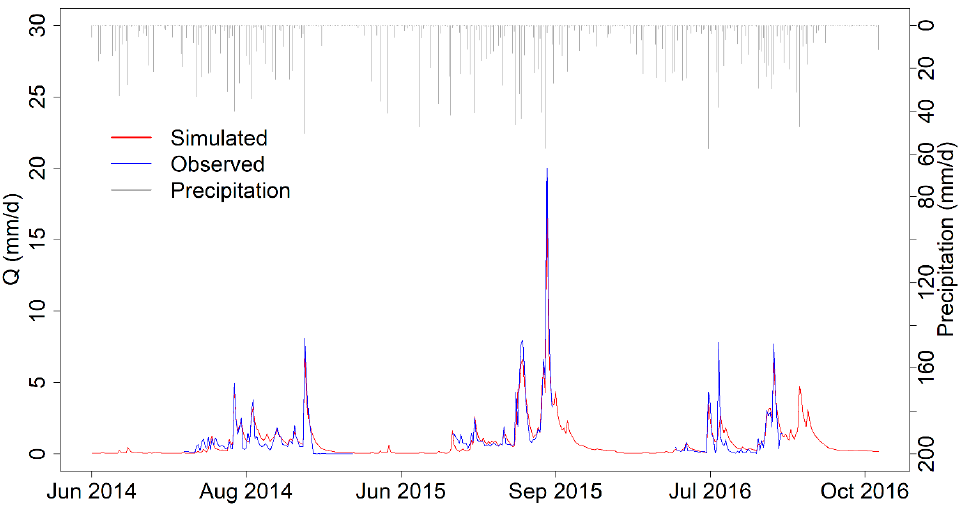
Figure 11. Comparison of the simulated Mebar hydrograph using the parameters from the best Bankandi ‐ Loffing simulation and the observed hydrograph from 2014 to 2016.